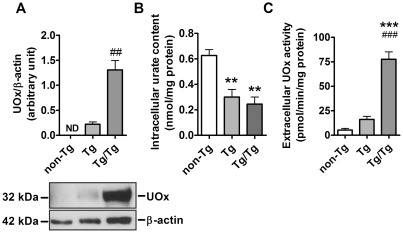
Characterization of non-Tg, Tg and Tg/Tg cortical neuron-enriched cultures.
A) Western blot and graph showing UOx expression in wild-type (non-Tg) and UOx-expressing neurons (Tg and Tg/Tg) normalized to the β-actin level. Note that UOx was not detected in wild-type neurons (n = 3). B) Effect of UOx expression on intracellular urate content in neurons normalized to the protein level (n = 3). C) UOx activity in the media of non-Tg and UOx-expressing neurons (n = 6). Student's t test: ##
P = 0.005 vs Tg value; one-way ANOVA followed by Newman-Keuls test: **P<0.01, ***P<0.001 vs non-Tg value and ###
P<0.001 vs Tg value.